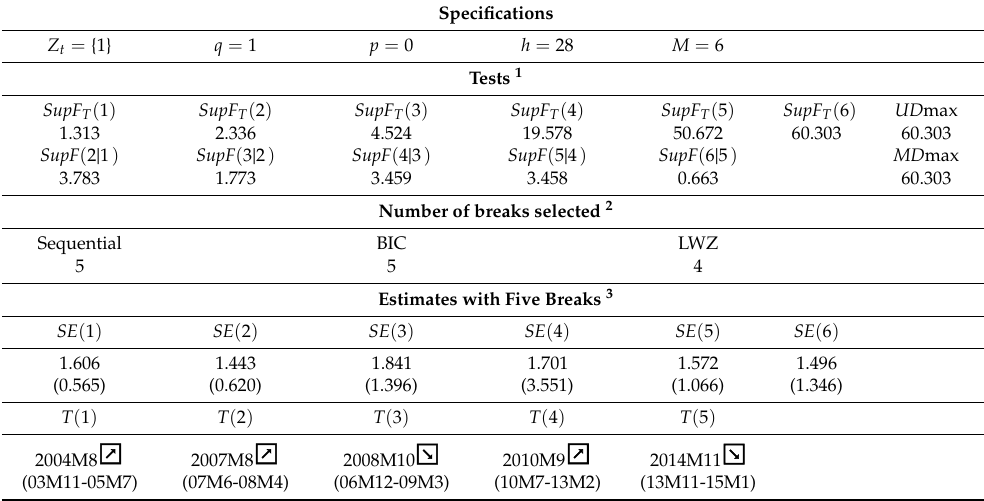
Table 3. Results of structural break tests.